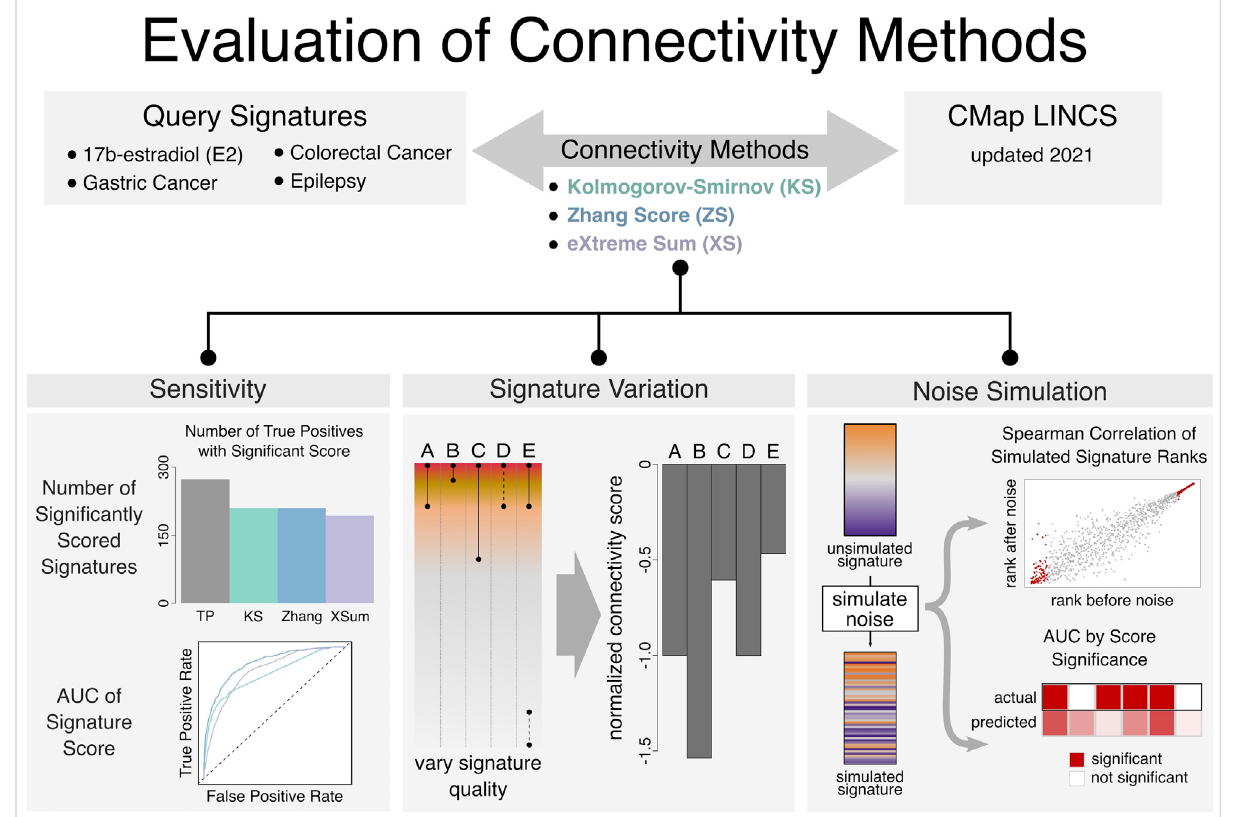
FIGURE 1 Evaluation of Connectivity Methods. Three disease and one compound signatures were retrieved from published literature and queried against theCMapLINCSdatabase(updatedin2021).Threeconnectivitymethods — KS,ZhangandXSum — wereevaluatedbasedontheirsensitivity,andtheir performance due to signature quality variation and noise in gene expression